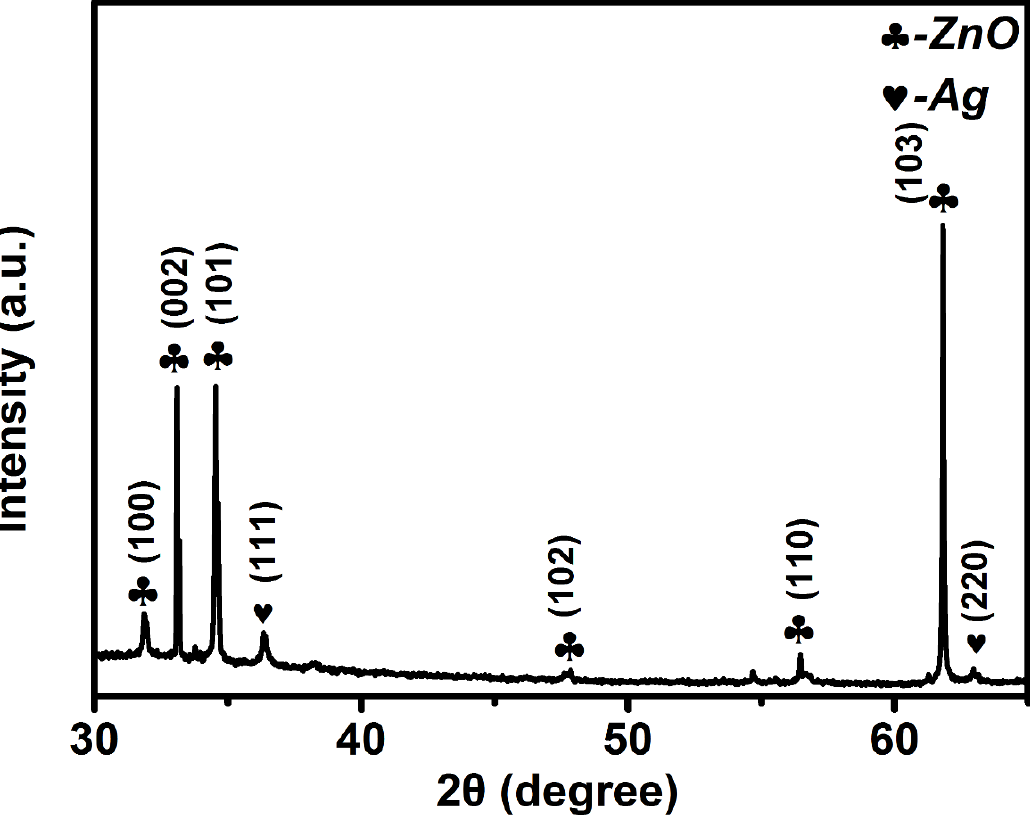
Materials 2021 , 14 , x FOR PEER REVIEW Figure 2. XRD spectra of the Ag-ZnO nanorod array. Figure 2. XRD spectra of the Ag–ZnO nanorod array.